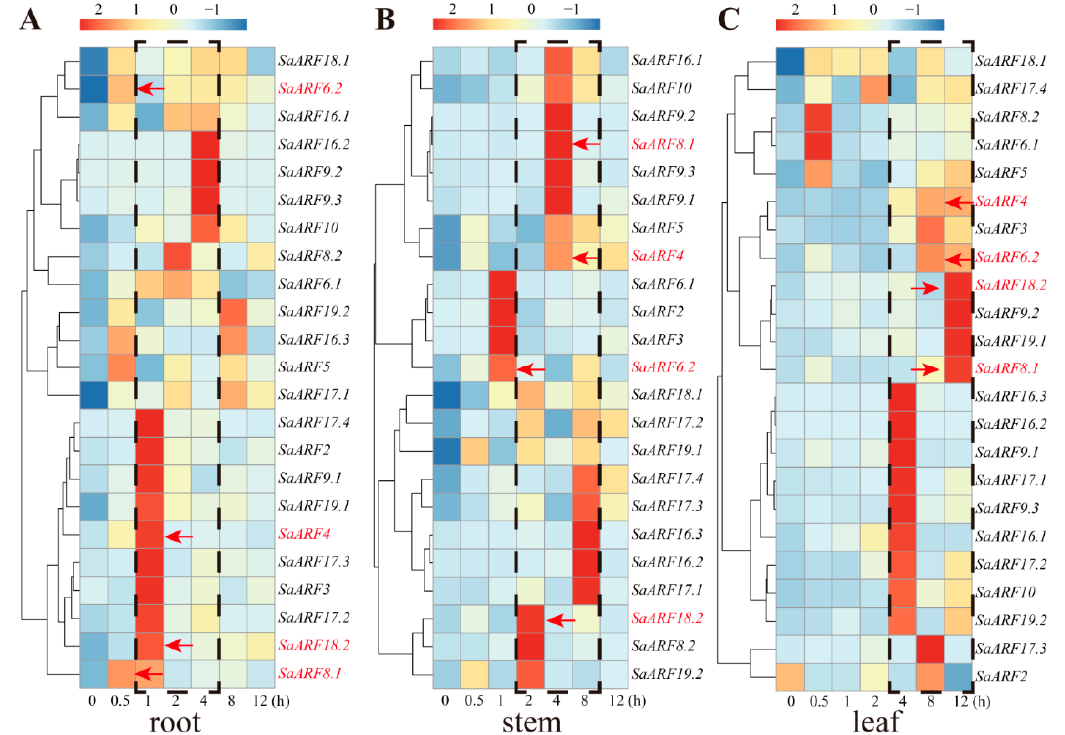
Figure 4. Expression patterns of SaARFs in different organs under Cd stress. ( A )The expression level of 14 SaARFs in roots under Cd stress. The black dotted box indicated the highest expression level of 14 SaARFs in roots were observed during 1–4 h. The red arrows indicated the highest level of corresponding SaARFs during Cd stress. ( B ) The expression level of 18 SaARFs in stems under Cd stress. The black dotted box indicated the peak values of 18 SaARFs expressions were distributed between 2–8 h. ( C ) The expression level of 18 SaARFs in leaves under Cd stress. The black dotted box indicated the peak values of 18 SaARFs expressions in leaves were mainly found after 4 h.